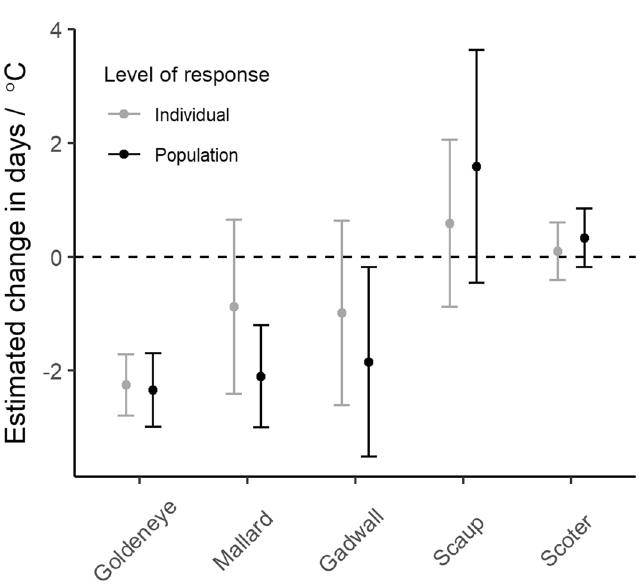
Figure 3. Comparison of estimates of population- and individual-level responses in clutch initiation date (95% CI) for spring temperatures. Similar estimates at both levels indicate that population-level responses are likely due to individual phenotypic plasticity. Goldeneye and mallard are early-nesters, gadwall mid-season nester, and scaup and scoter are late-nesters. Sample sizes in Supplementary Table